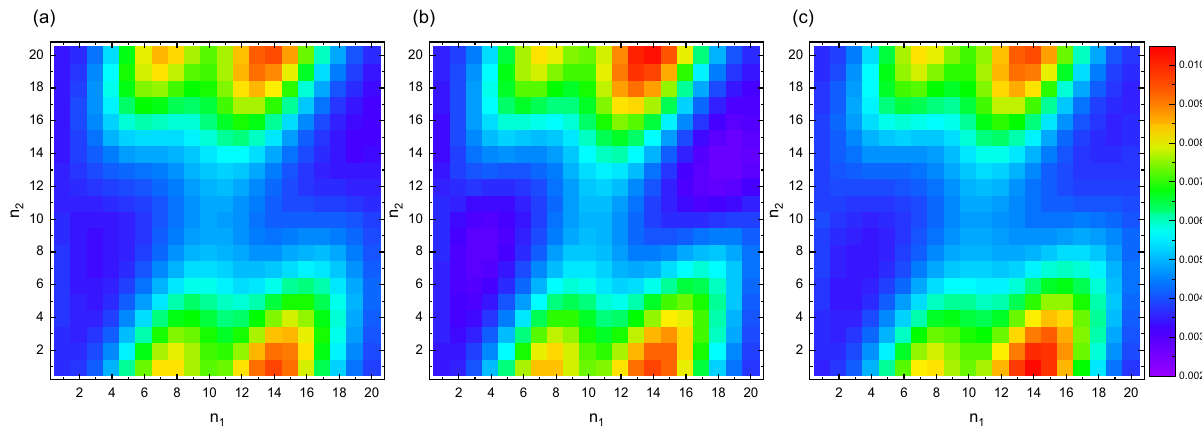
Fig. 5 Many-body Berry curvature as a function of discretized boundary phases. a Sector ( k 1 , k 2 ) = (0, 0), b sector (0, 2), and c sector (0, 4). Parameter values are t δ = 0.5, r 2 = − 0.2, λ = 0.2 with U = 2 and V